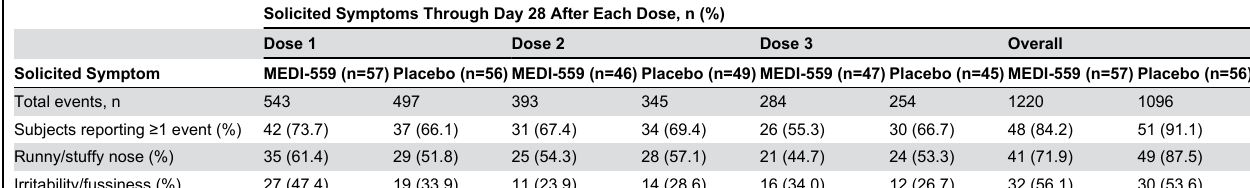
Solicited Symptoms Through Day 28 After Each Dose, n